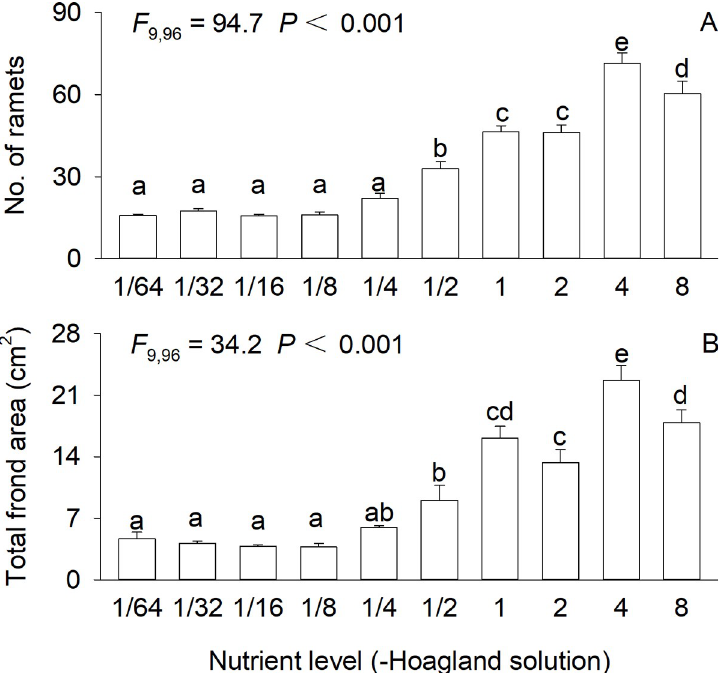
Fig 2. Ramet number (A) and total frond area (B) of Spirodela polyrhiza grown in ten concentrations of Hoagland nutrient solution. Bars and vertical lines indicate means and SE (n = 12). F-statistics, df and P-values of one-way ANOVA for the effects of nutrient level are also given. Bars sharing the same letters are not different at P = 0.05.